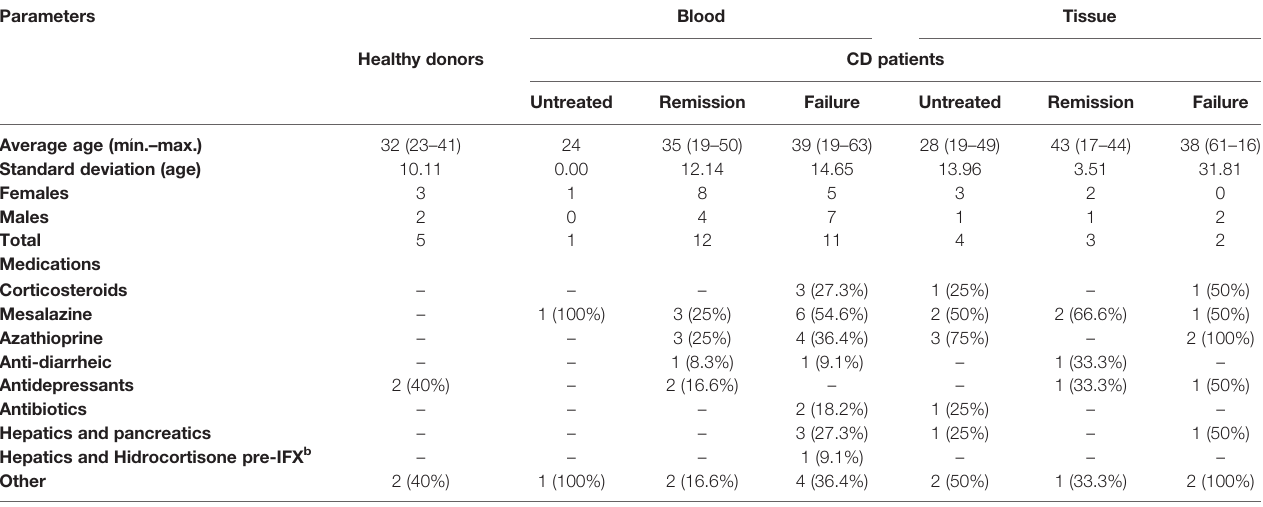
TABLE 1 | Characteristics from CD a patients and healthy donors. Parameters